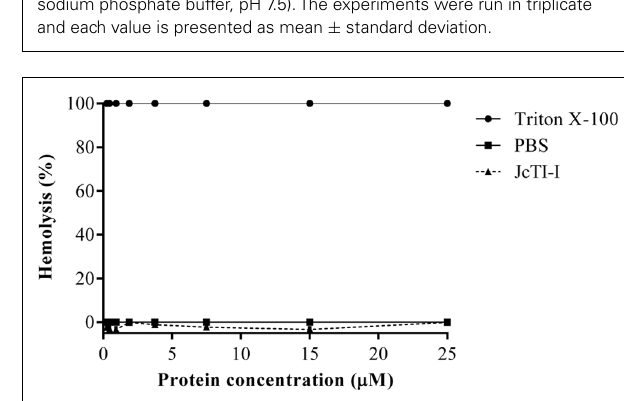
FIGURE 7 | Inhibitory effect (%) of JcTI-I on the proteases extracted from Staphylococcus aureus and Salmonella enterica . Asterisks represent significant difference ( P < 0.05) in comparison to control (0.25 M sodium phosphate buffer, pH 7.5).The experiments were run in triplicate and each value is presented as mean ± standard deviation.